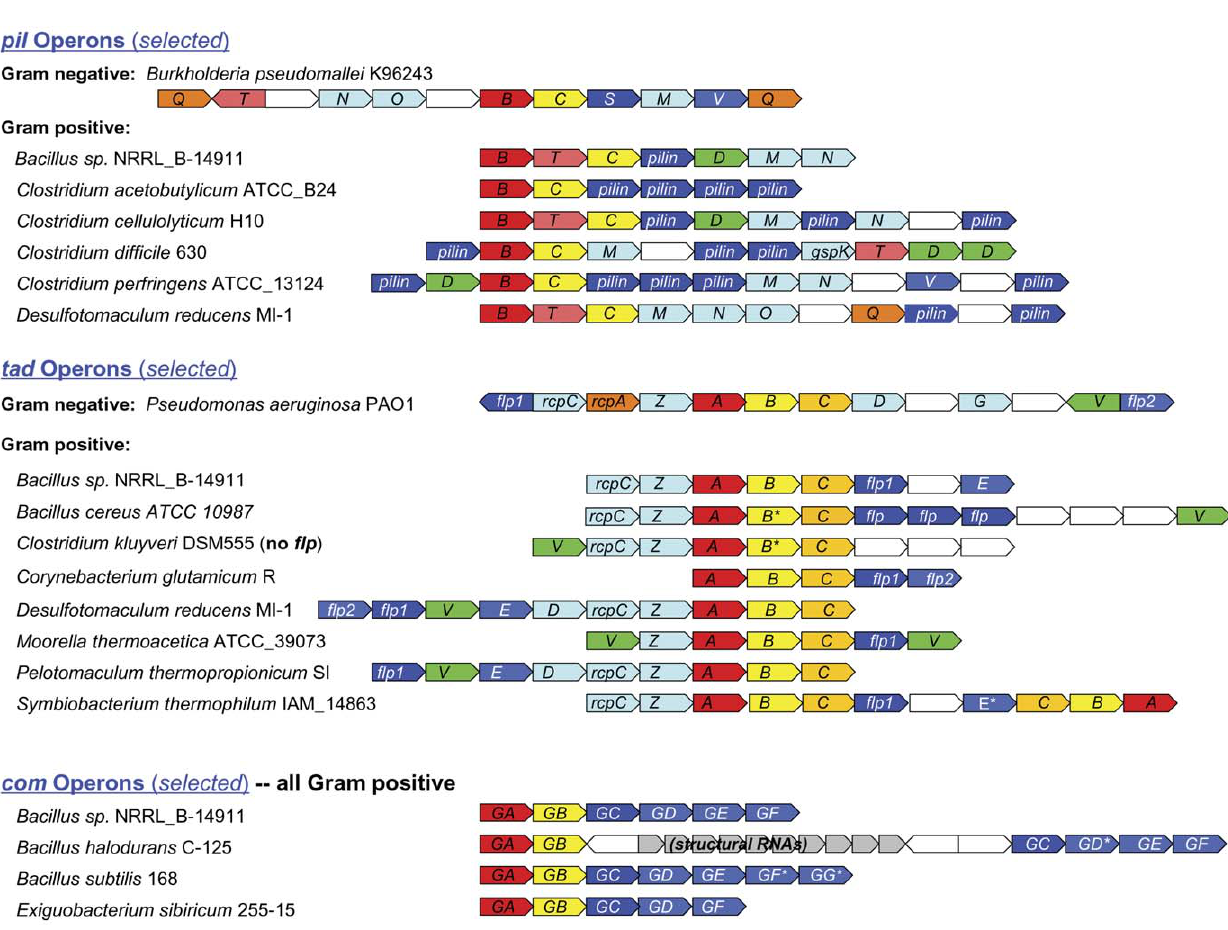
The result is a hydrophobic N-terminus, usually containing a glutamate or aspartate (E/D) at position + 5, part of a motif that facilitates assembly of a scaffold mediating pilus assembly [1]. Flp (fimbrial low-molecular protein weight) proteins are unusually small type IV pilins ( , 60 amino acids vs. , 200 for pil pilins are located within tad ( t ight ad herence) loci, along with the